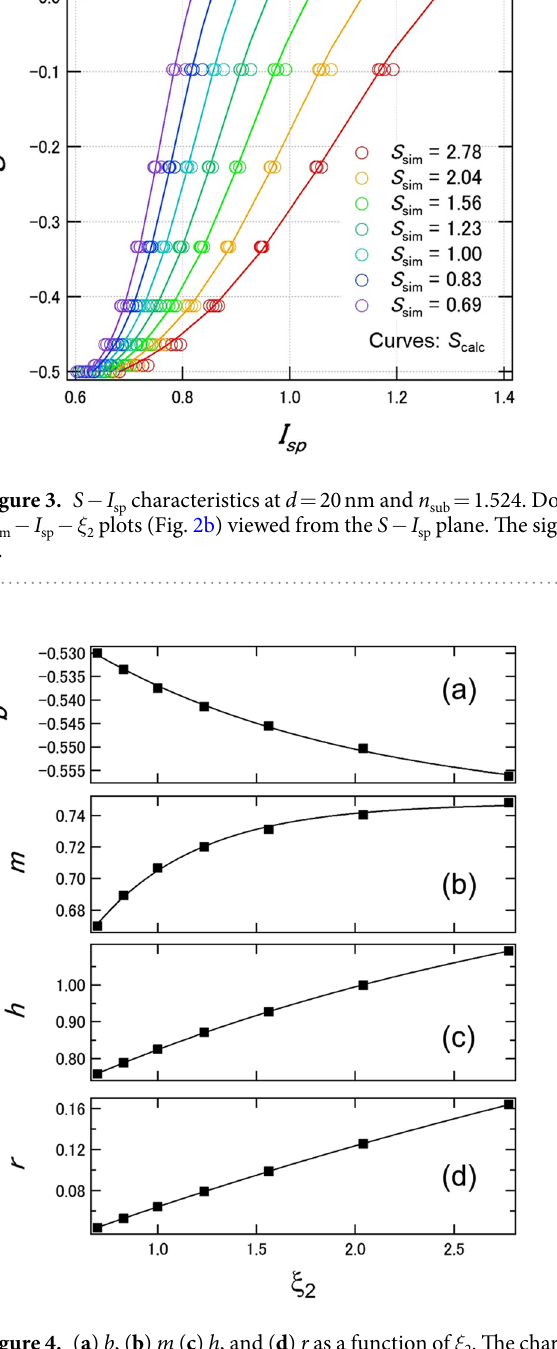
Figure 4. ( a ) b , ( b ) m ( c ) h , and ( d ) r as a function of ξ 2 . The characteristics were obtained at d = 20 nm and n sub =